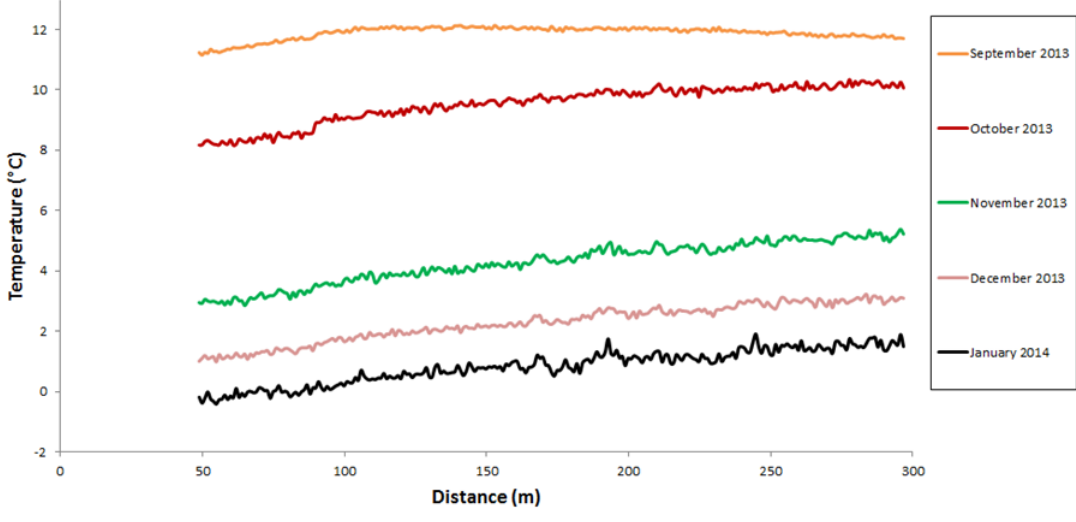
Figure 5. Seabed sediment temperatures measured from September 2013 to January 2014 in Liito-oravankatu.